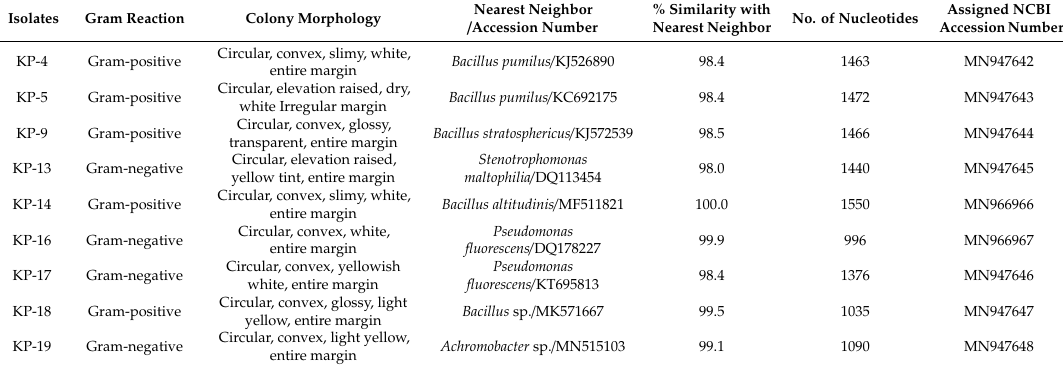
Table 1. Identification of isolated strains based on their 16S rDNA sequences and NCBI GenBank database. Isolates GramReaction ColonyMorphology NearestNeighbor / AccessionNumber %Similaritywith NearestNeighbor No. ofNucleotides AssignedNCBI